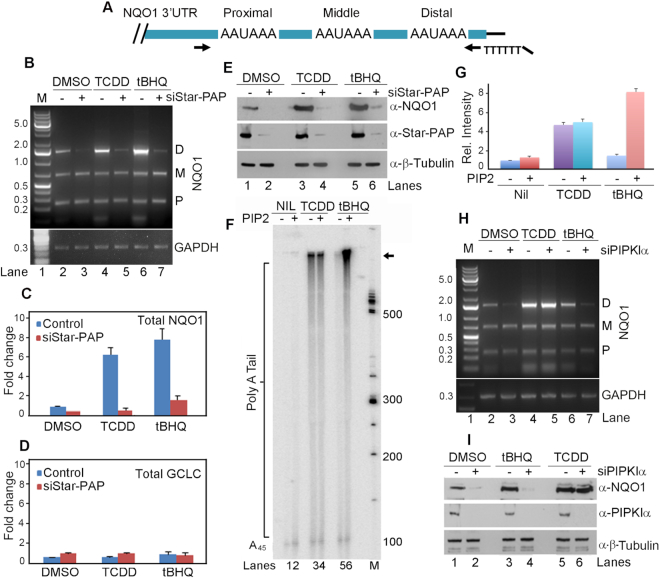
Alternative polyadenylation (APA) at the NQO1 3′-UTR generates three mRNA alternate isoforms that is signal regulated. (A) Schematic of NQO1 mRNA 3′-UTR depicting distribution of the three PA-sites (PAS) and the position of the gene specific primer and engineered oligodT primer employed in the 3′-RACE assay. (B) 3′-RACE analysis of the PA-site usage within NQO1 and control GAPDH pre-mRNA 3′-UTR in the presence or absence of Star-PAP knockdown after DMSO, tBHQ and TCDD treatment in HEK 293 cells. Products corresponding to the usage of the three PA-sites (proximal, P; middle, M; distal, D) on the NQO1 3′-UTR are indicated. Each gel is representative of n = 3 independent experiments. (C, D) qRT-PCR analysis of NQO1 and a Star-PAP non-target GCLC under conditions as in B (P-values - DMSO 0.01, tBHQ 0.045, and TCDD 0.03 for NQO1; P-values <0.02 for GCLC under all three conditions). Error bar represents standard error mean (SEM), (n = 3). (E) Western blot analysis of NQO1, Star-PAP and control β-tubulin from HEK 293 cells under the same condition as in B. Each blot is representative of n = 3 independent experiments. (F) In vitro polyadenylation assay carried out with the FLAG-Star-PAP complex isolated from stable expressing FLAG-Star-PAP in HEK 293 cells after treatment with DMSO, tBHQ and TCDD using a 45-mer RNA oligonucleotide template having a repeat sequence UAGGGA followed by a stretch of 15 adenosines, (UAGGGA)5A15 (A45) (5) in the presence or absence of PI4,5P2 as indicated. Each autoradiogram is representative of n = 3 independent experiments. (G) Densitometric quantification of intensities of bands in phosphor images of PAP assays in F in arbitrary units expressed as relative intensity with respect to the intensity of FLAG-Star-PAP alone (quantified regions on the gel is indicated by an arrow). Data are mean ± SEM of n = 3 independent experiments. (H, I) 3′-RACE and Western blot analysis as in B and E respectively but in the presence and absence of PIPKIα knockdown as indicated. Each gel is representative of n = 3 independent experiments.